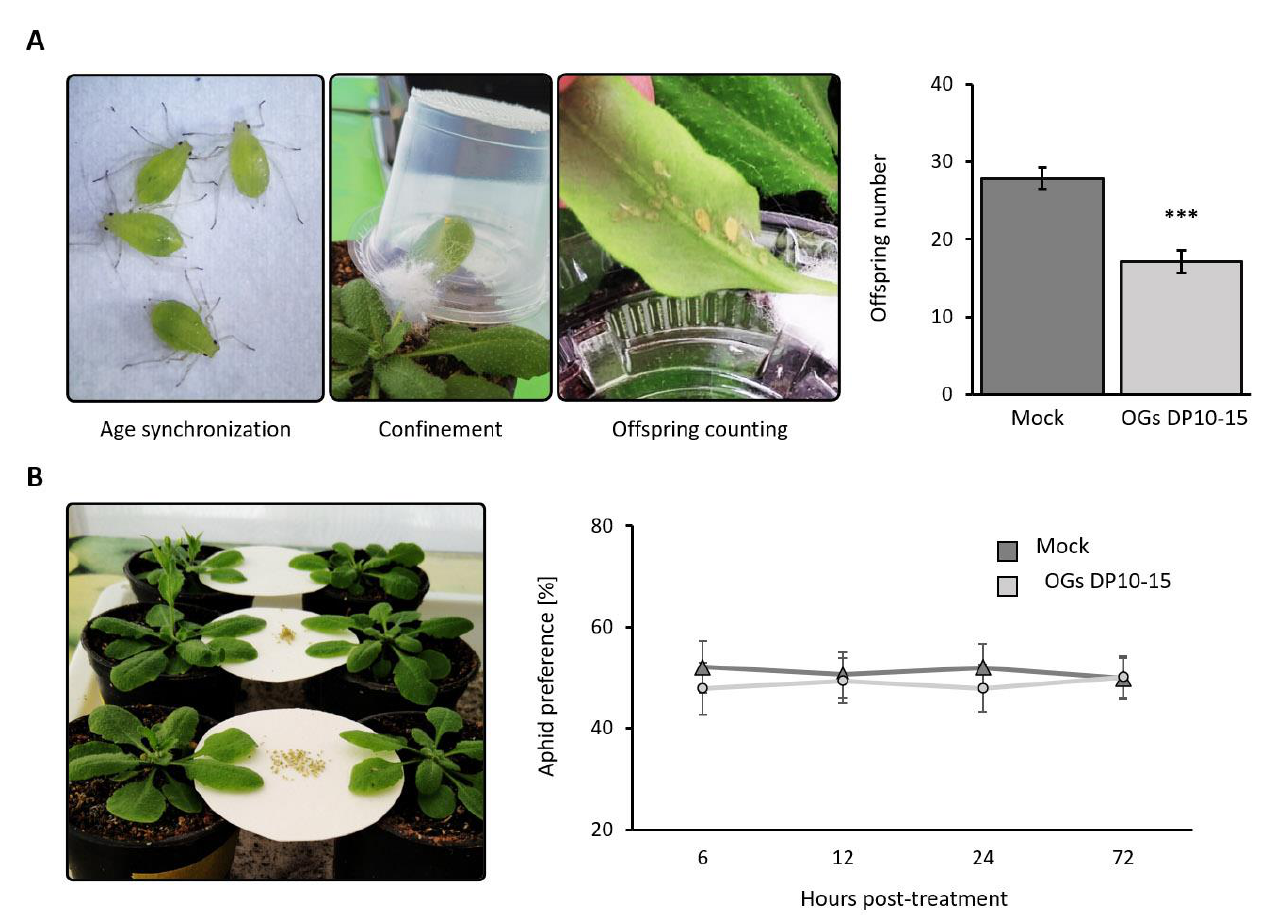
Figure 1. Treatment with OGs decreases the number of aphid offspring. ( A ) A no-choice assay was performed to determine the effect of OG treatment on the number of offspring deposited by Myzus persicae aphids. Fully expanded leaves of 4-week-old Arabidopsis plants were infiltrated with OGs having a degree of polymerization of 10–15 (DP 10–15) (200 µ g mL − 1 ) or ultrapure water (mock). One-day-old nymphs were confined to the treated leaves, and 12 days after treatment, the offspring were counted. Error bars correspond to standard error. Asterisks represent significant differences determined using Student’s t -test (***, p < 0.001; n = 6). ( B ) A free-choice assay was executed to determine the settling preference of M. persicae. Fully expanded leaves of 4-week-old Arabidopsis plants were infiltrated with OGs (DP 10–15; 200 µ g mL − 1 ) or ultrapure water (mock). Subsequently, 30 adult wingless aphids were placed between the treated leaves to freely choose their preferred host at different post-treatment temporalities. The Student’s t -test was used for comparing means. The error bars correspond to standard error. No significant differences were found at any of the temporalities assayed ( p > 0.05; n =